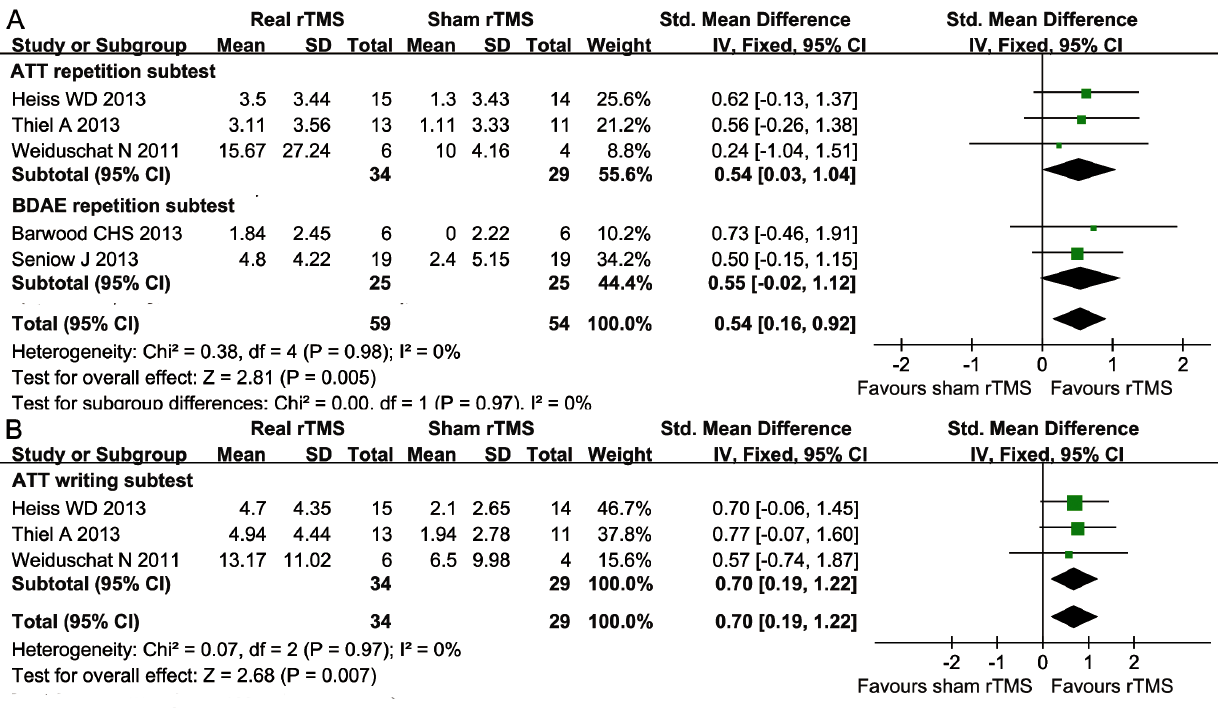
Figure 5. Forest plot of SMD and 95% CI for the outcome of repetition (A) and writing (B) in patients received rTMS and sham rTMS.